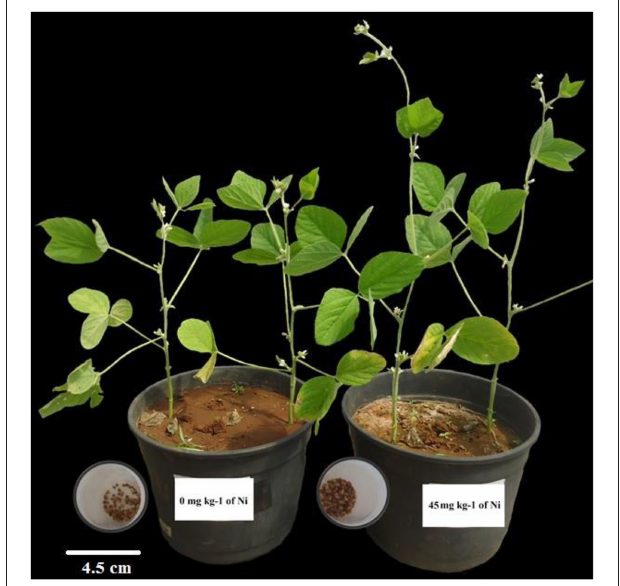
FIGURE 6 | Visual aspects of soybean cultivar BMX Potência RR growth at reproductive phonological stage (R1, Fehr et al., 1971) and its fresh nodules collected at this stage, as related to Ni seed treatments of control and Ni rate of 45mg kg − 1 .